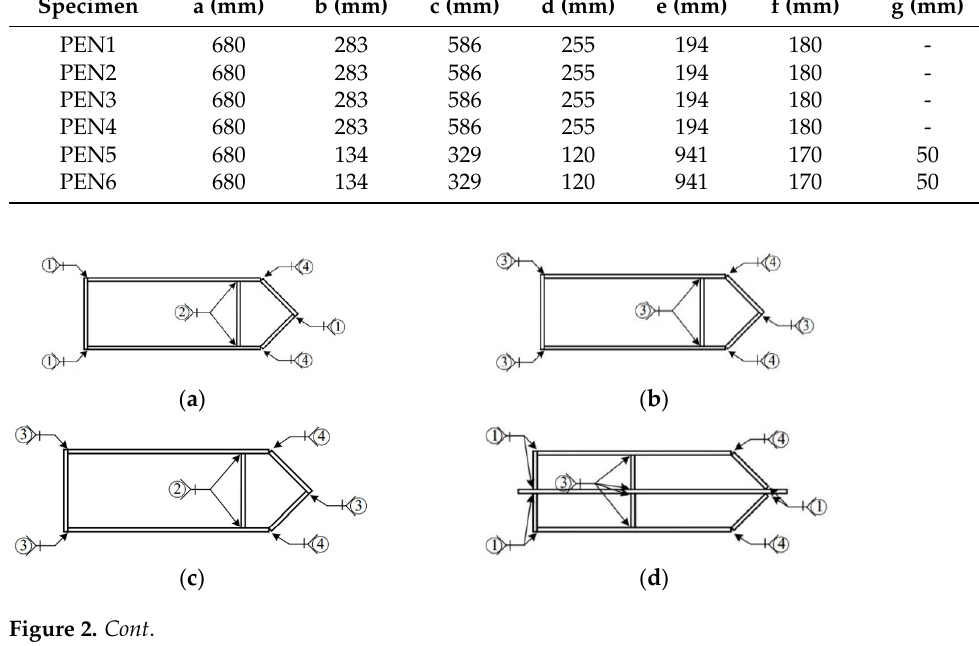
Figure 1. Cross ‐ section shape of the specimens. ( a ) 2 ‐ cell specimens; ( b ) 4 ‐ cell specimens. Figure 1. Cross-section shape of the specimens. ( a ) 2-cell specimens; ( b ) 4-cell specimens. Table 1. Dimensions of test specimens.